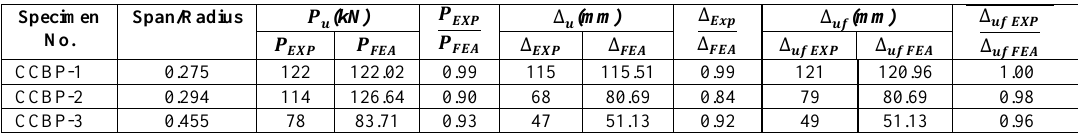
Figure 8. Maximum principle stress contour for CCBP-2 Table 3. Comparison between the numerical and experimental